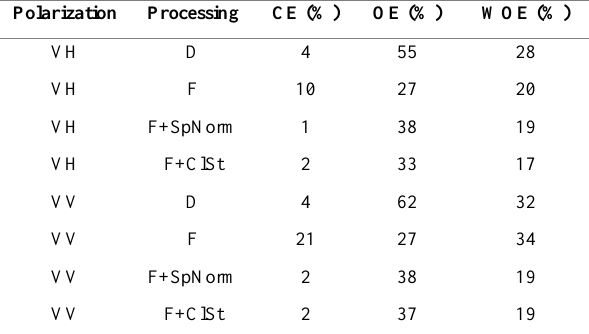
Table 3. Results of the deforestation detection procedure for a 0.01 significance. D: Original data. F: Filtered data. SpNorm: Spatial normalization. ClSt: Climate Stabilization. CE: Commission errors. OE: Omission errors. WOE: Weighted overall error.